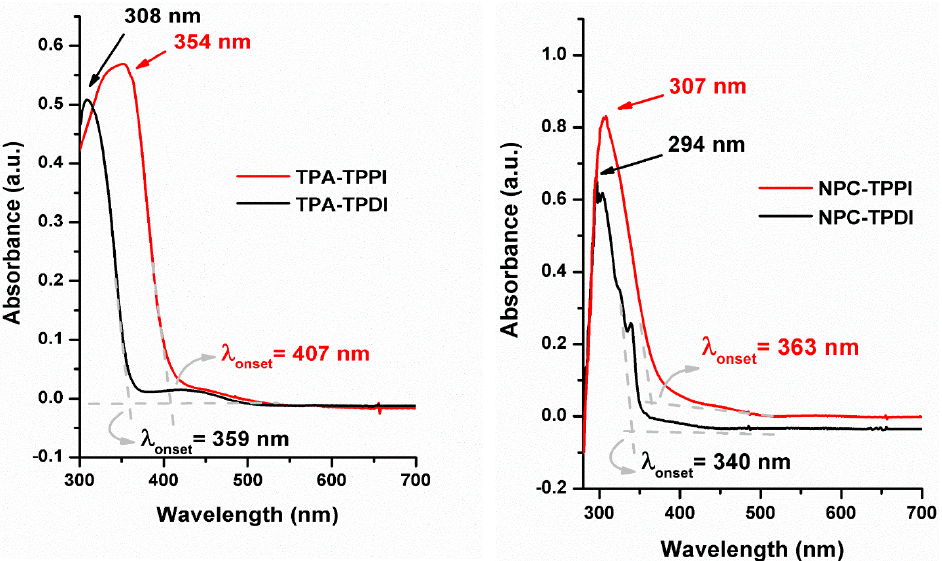
Figure 13. UV–Vis absorption spectra of TPA–TPDI and NPC–TPDI in CH 2 Cl 2 and the films of TPA–TPPI and NPC–TPPI on ITO-glass.